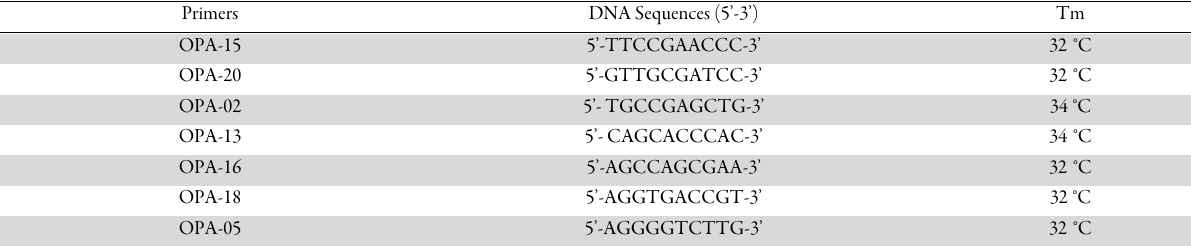
Table 1. Primers used in the RAPD-PCR reactions and their Tm degrees